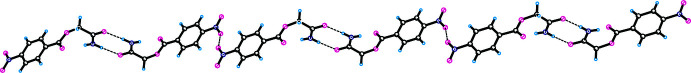
Hydrogen bonds and inter­molecular O⋯O contacts in II.